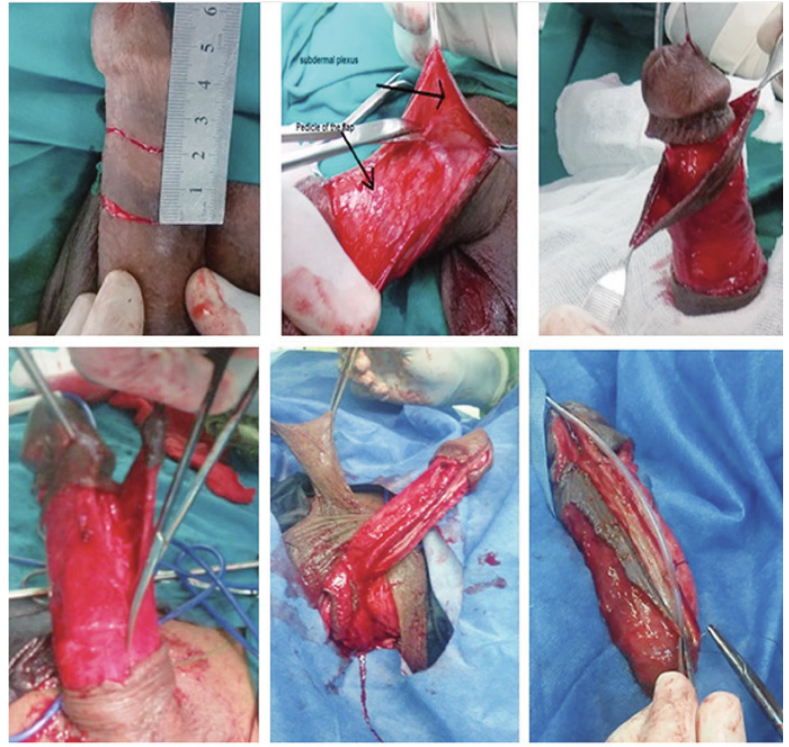
Figure 3 - ventral onlay circular penile flap